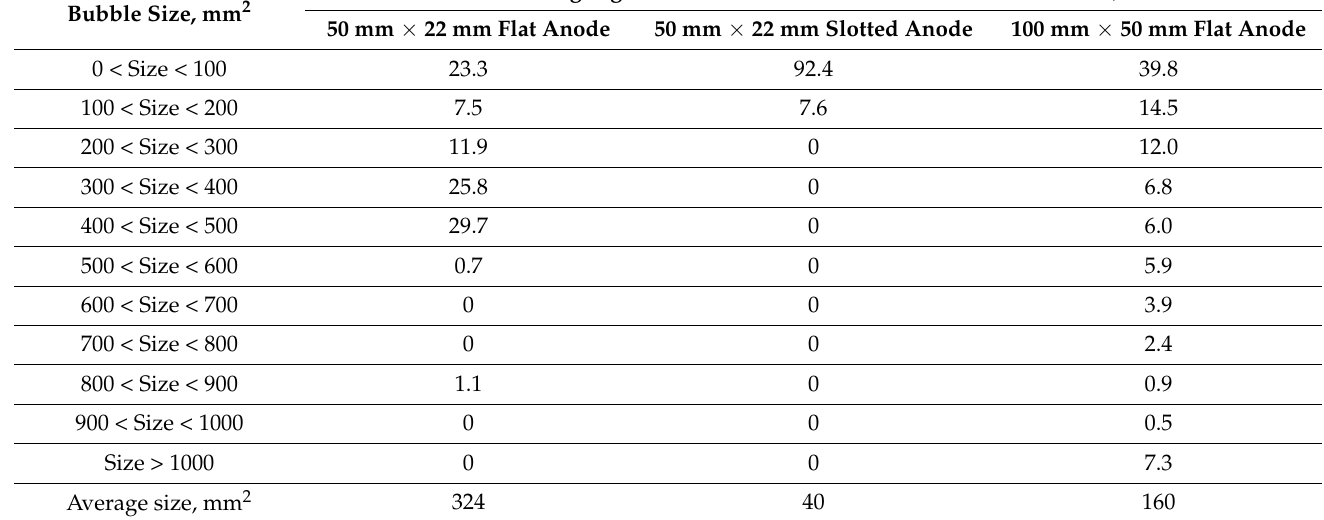
Table 2. The size distribution of the bubbles obtained from the see-through cell experiments, apparent anode current density 0.9 A/cm 2 . Percentage against the Total Bubble Area Counted within 60 s, % Bubble Size, mm 2 50 mm × 22 mm Flat